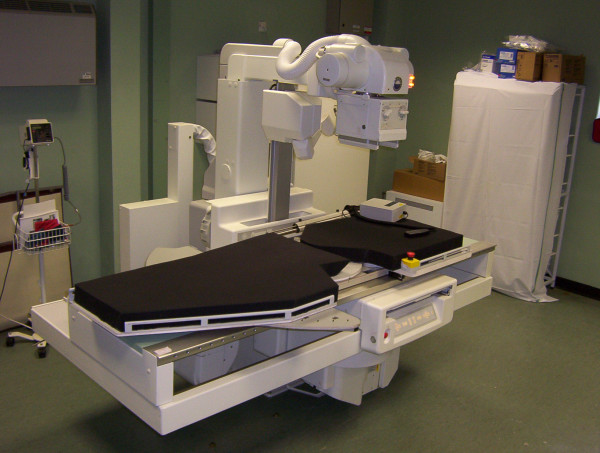
Swing table and fluoroscope configuration. (Atlas Clinical Ltd)